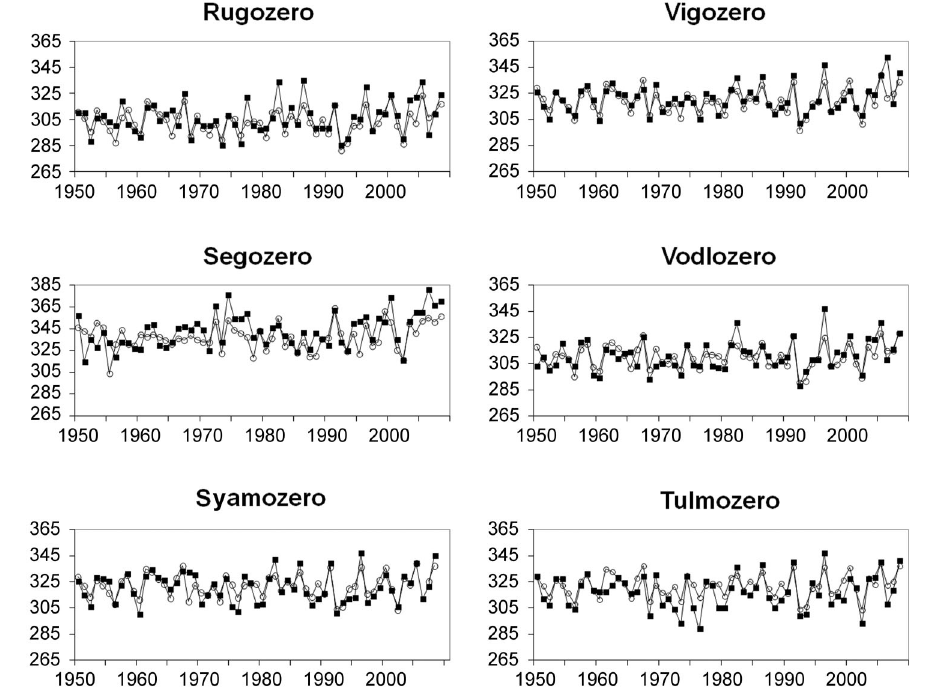
Fig. 6. Observed (line with black squares) and modelled (line with white circles) dates of freeze-up of the studied lakes in Karelia.